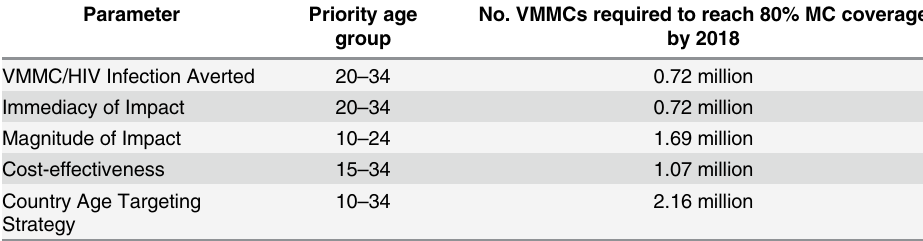
Table 1. Priority age groups and number of VMMCs required for each parameter in the model frame- work, Tanzania.